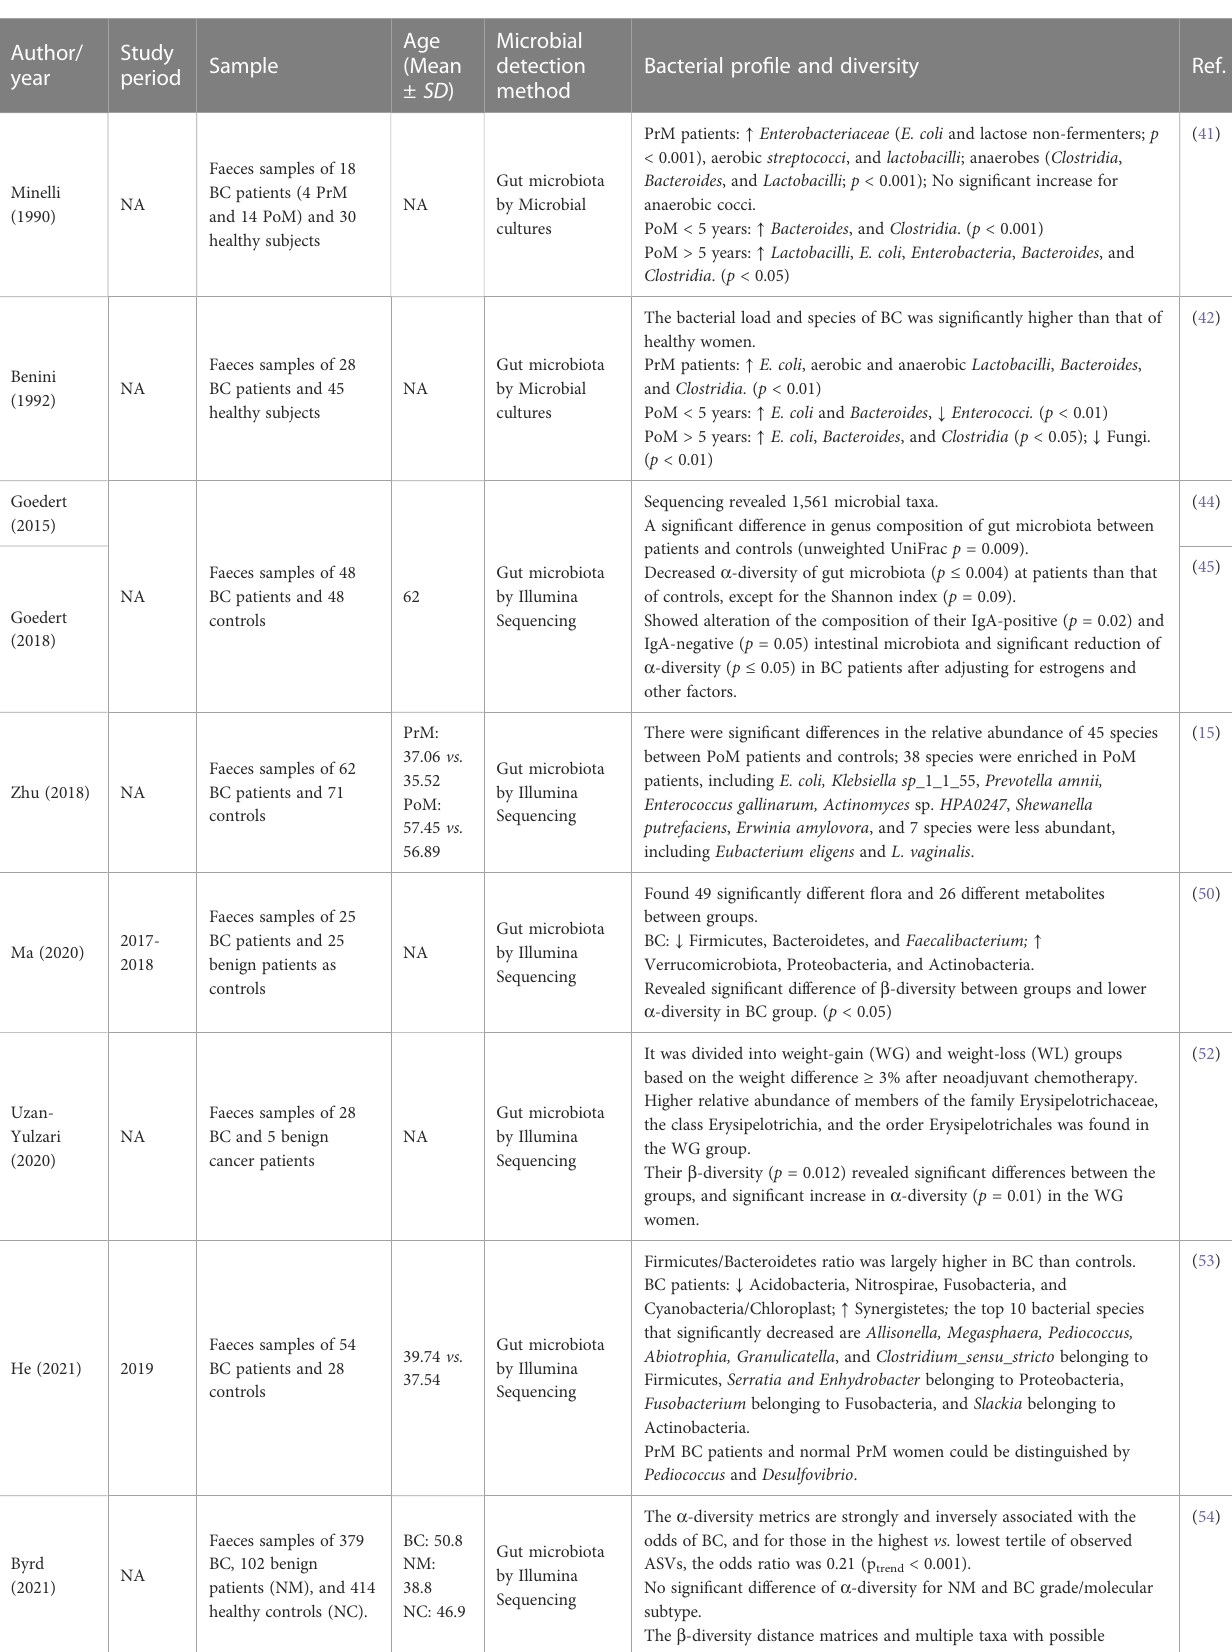
TABLE 5 Characteristics of case-control studies and their microbial pro fi ling and